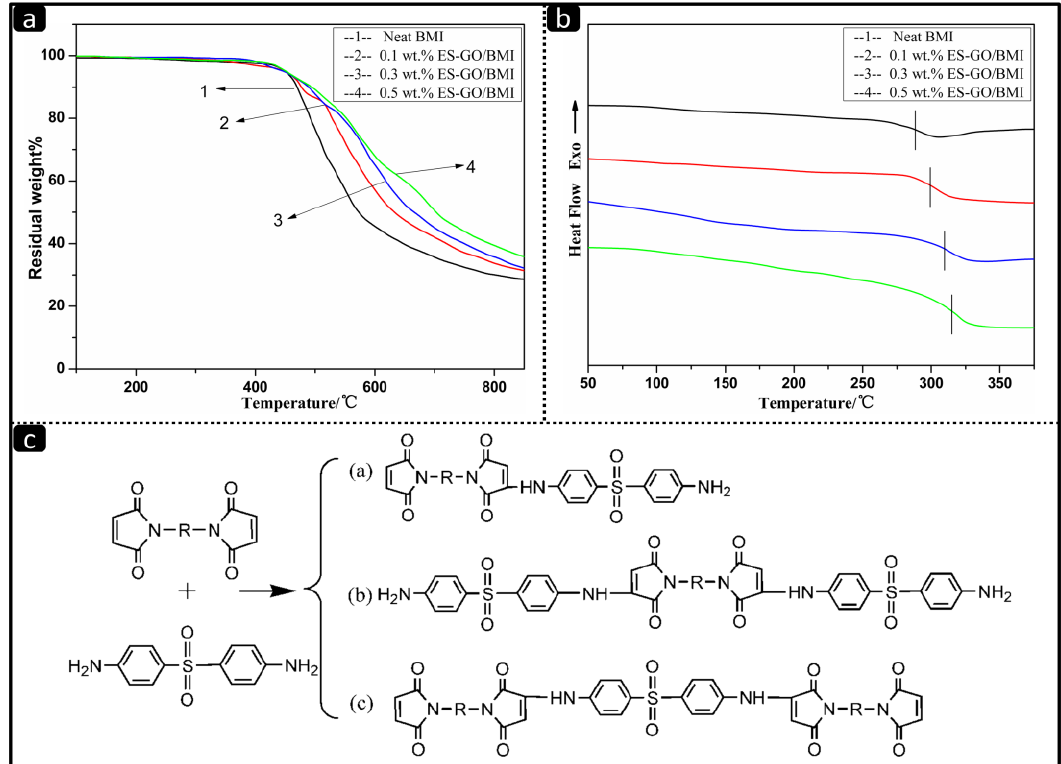
Figure 3. ( a ) Thermogravimetric analysis (TGA) curves of cured resin systems with di ff erent amount of ES-GO; ( b ) Di ff erential scanning calorimeter (DSC) curves of cured resin systems with various amounts of ES-GO; ( c ) Proposed reactions in the process of 4,4-Diaminodiphenyl sulfone (DDS) chain extension of BMI. Table 1. Thermal properties of systems modified with various contents of ES-GO. ES-GO Content (wt.%)